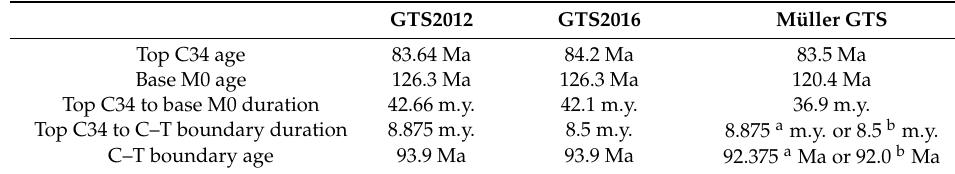
Table 1. Geologic time scales, durations and ages of key boundaries. GTS2012 = The Geologic Time Scale for the Cretaceous Period [50]; GTS2016 = Concise Geologic Time Scale 2016 [48]; Müller GTS according to